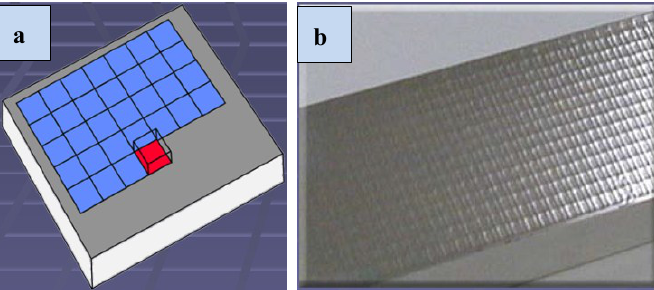
Figure 23. Square shaped beam pattern ( a ) and a peened component ( b )